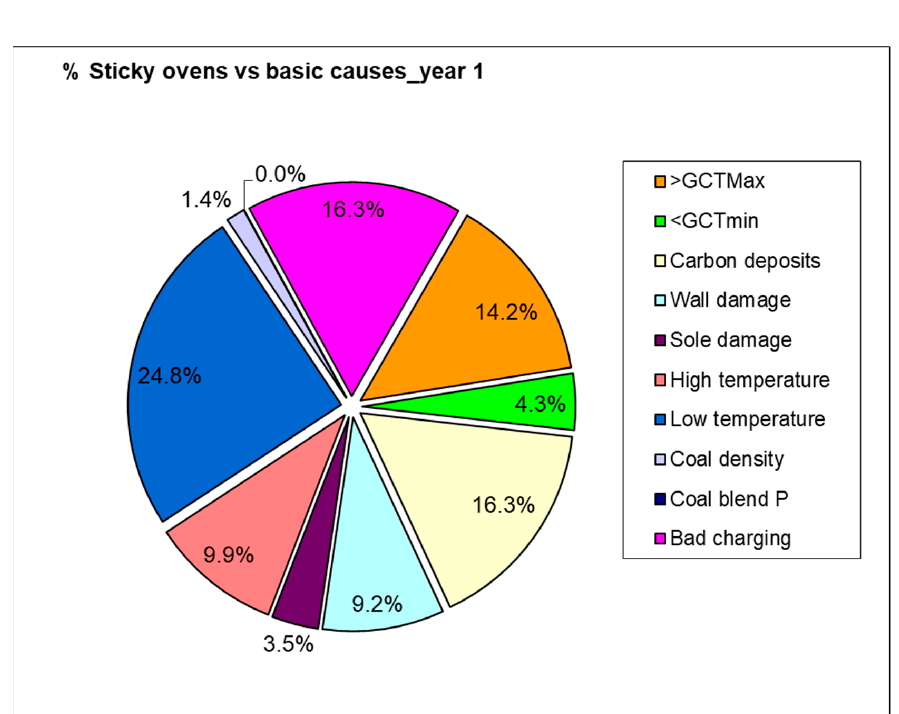
Figure 6. Causes of sticky ovens in the first year.